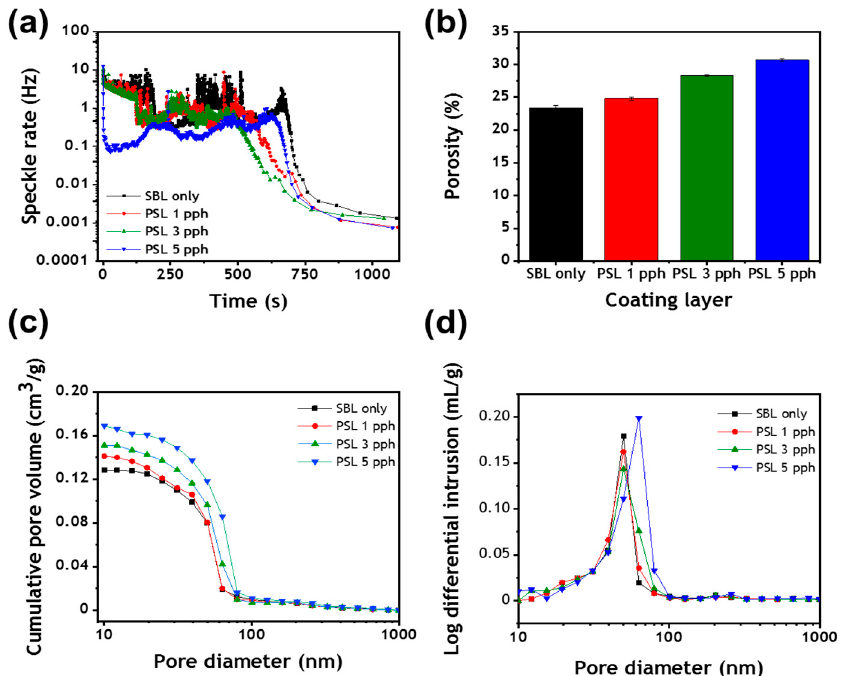
Figure 4. ( a ) Drying kinetics of coating layers, ( b ) porosity of coating layers, ( c ) cumulative pore volume of dried coating layers containing various proportions (parts per hundred; pph) of polymer-stabilized (PS) latex, and ( d ) effect of PS latex dosage on the pore size distribution of the coating layers.